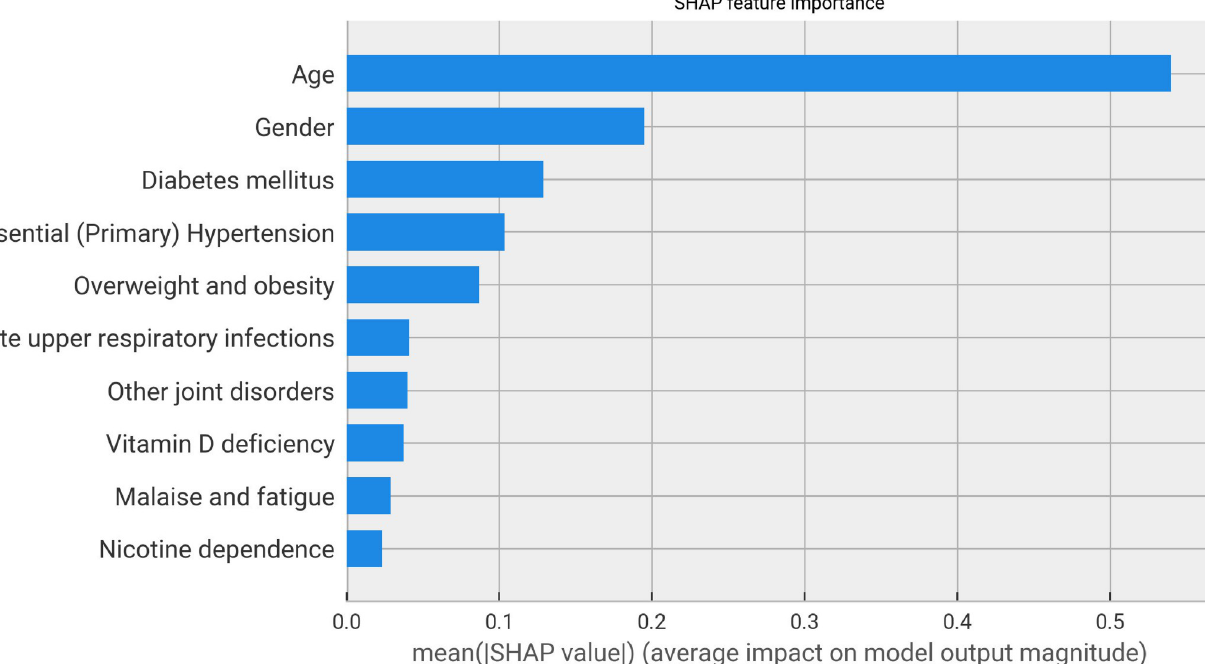
PLOS ONE | https://doi.org/10.1371/journal.pone.0271227 July 28,